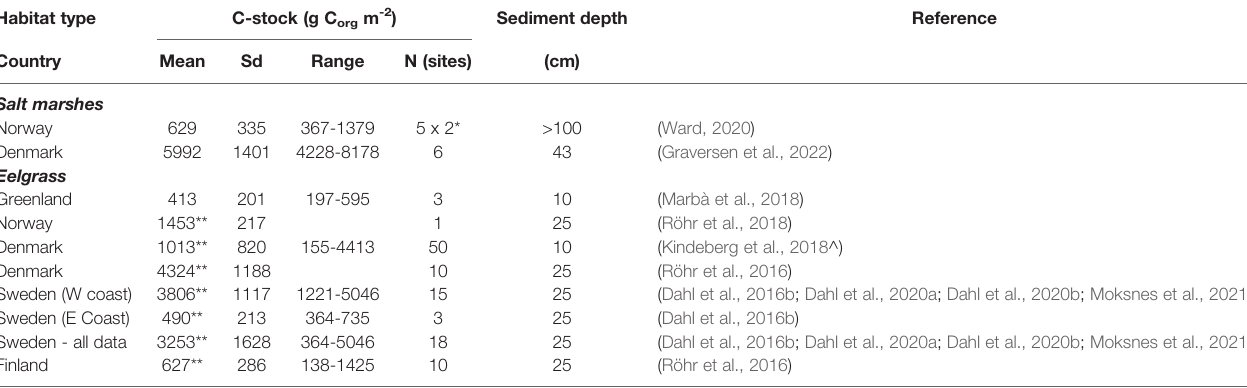
TABLE 2 | Sediment organic C-stocks of Nordic BC habitats with indication of mean levels, standard deviation (sd), range, and number of observations